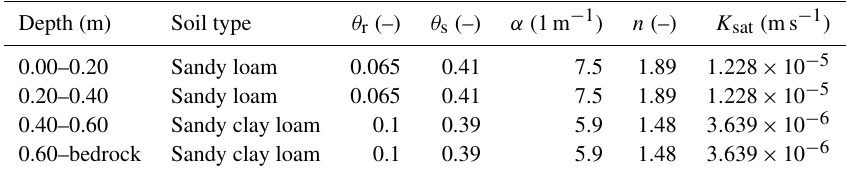
Table 2. Vertical profile of soil characteristics at Howard Springs, based on data from the Soil and Landscape Grid of Australia (Vis- carra Rossel et al., 2014a, b, c), in addition to field measurements of Jason Beringer and Lindsay B. Hutley. Here, θ r refers to the residual moisture content, θ s to the saturated water content, α and n to the Van Genuchten soil parameters (van Genuchten, 1980) and K sat to the saturated hydraulic